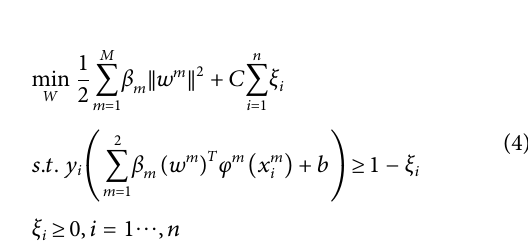
FIGURE 2 | The accuracy of different hyperparameters λ for the